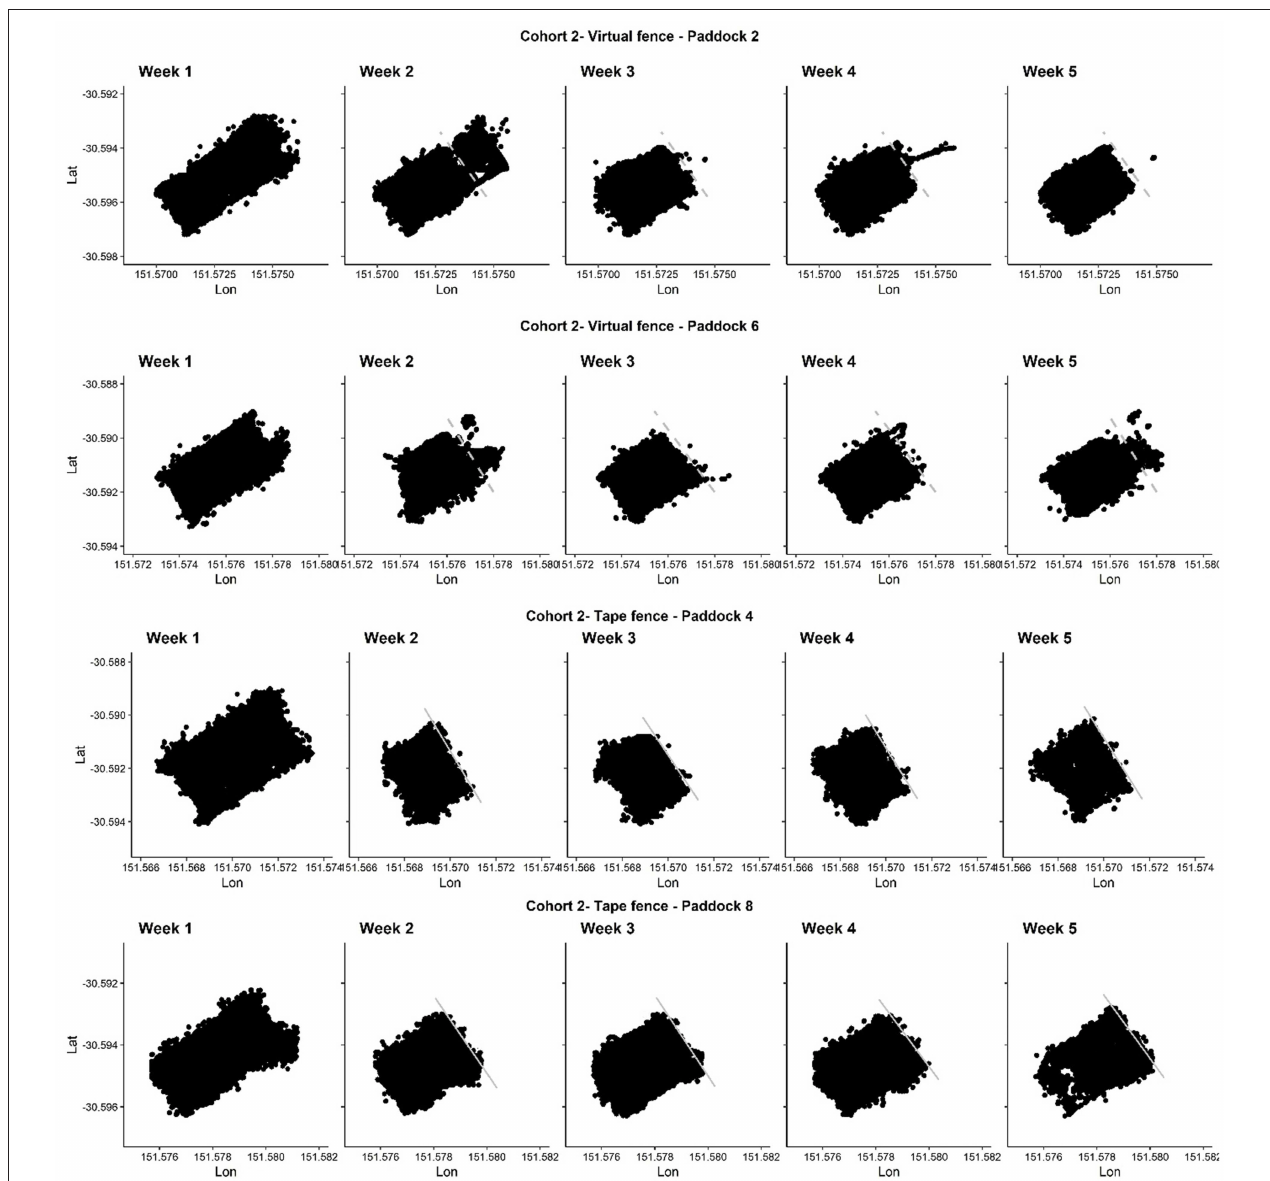
FIGURE 4 | The GPS locations (latitude and longitude) of four cattle groups in cohort 2 across each week of the trial. An electric tape fence (solid lines) or a virtual fence (dashed lines) was placed/activated at the beginning of week 2 (NB: week 5 in cohort 2 consisted of only 3 days due to early experiment termination). The fence type and paddock number (as related to Figure 1 ) is indicated. On week 2 in paddocks 2 and 6 cattle did cross over the virtual lines as they were learning the cues. Dots are GPS locations of individual cattle that were recorded every second when the animals were within a specified distance (value commercial in confidence) from the virtual fence line and/or walking/grazing. The shape of the GPS dots aligns with the shape of the paddocks as per Figure 1 indicating cattle used all available areas during week 1 and were subsequently restricted by the fence. Dots outside of the paddock boundaries indicate GPS error. On week 5 in paddock 6, an extra 7h of recording past the fence shut down is displayed (fence was turned off at 17:00, the neckbands recorded until 00:00) showing animals crossing into the previously excluded area. On week 5 in paddocks 4 and 8, the electric tape was shifted to expose more grazing area (to compensate for a decrease in body weight). The virtual fences were not moved as these animals were not exhibiting the same decrease in body weight and any increased grazing near the shifted line may have subsequently impacted the degree of interaction with the virtual fence at the later trial stages.